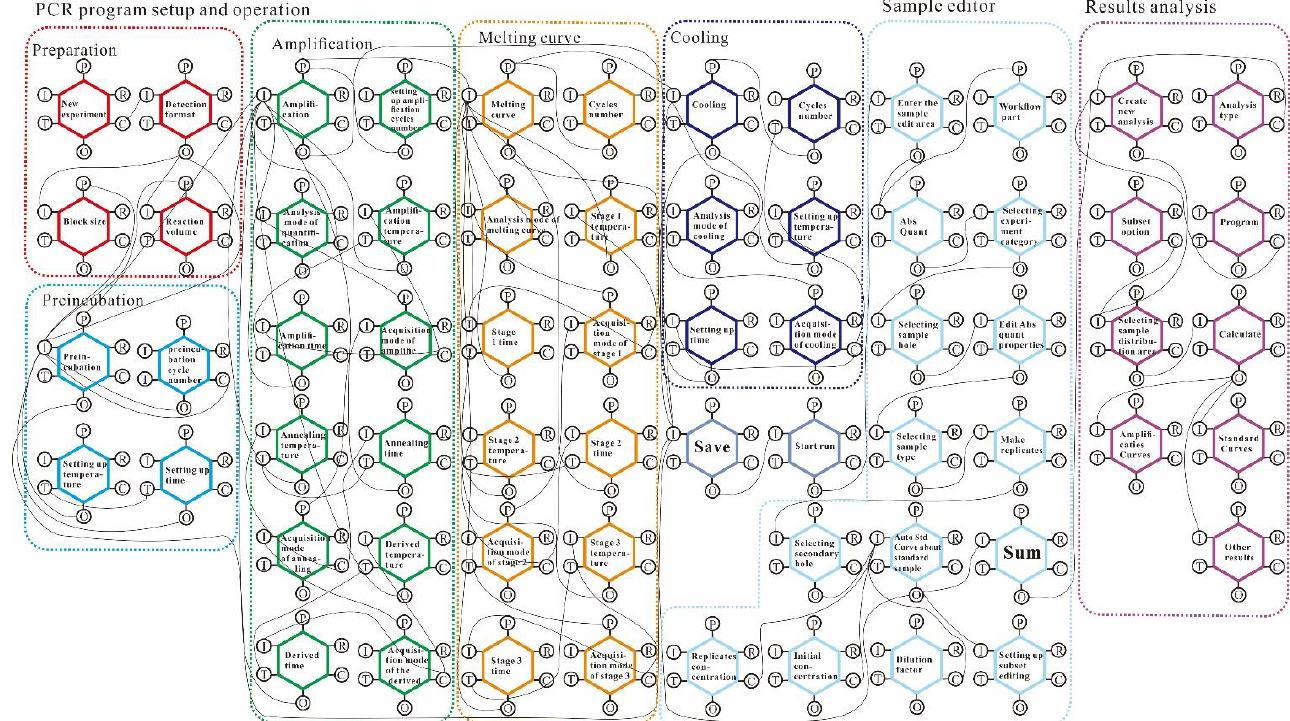
Figure 5. The systemic FRAM model built for the PCR interface operation process.